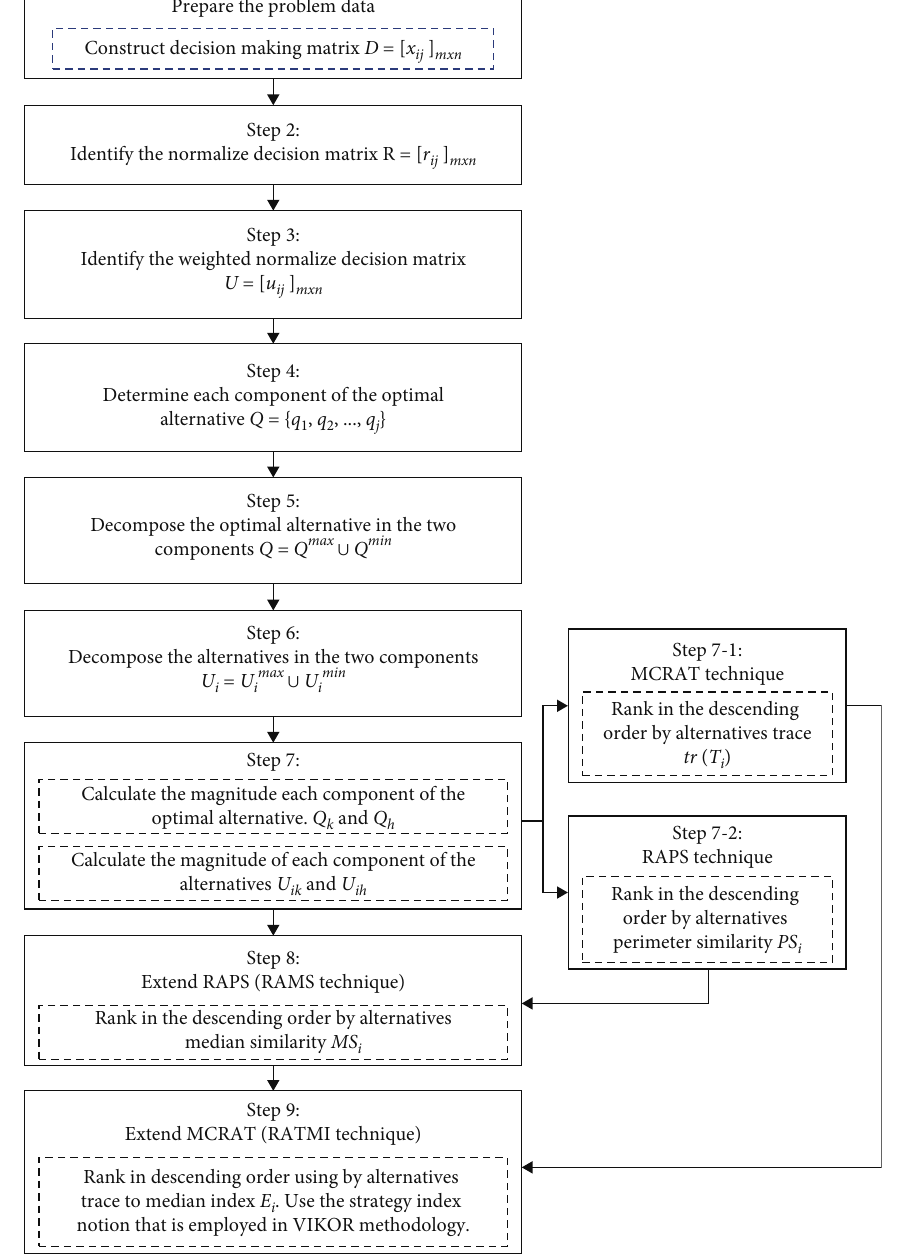
Figure 1: Steps of RAMS and RATMI